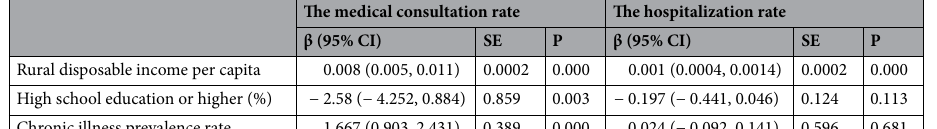
The medical consultation rate The hospitalization